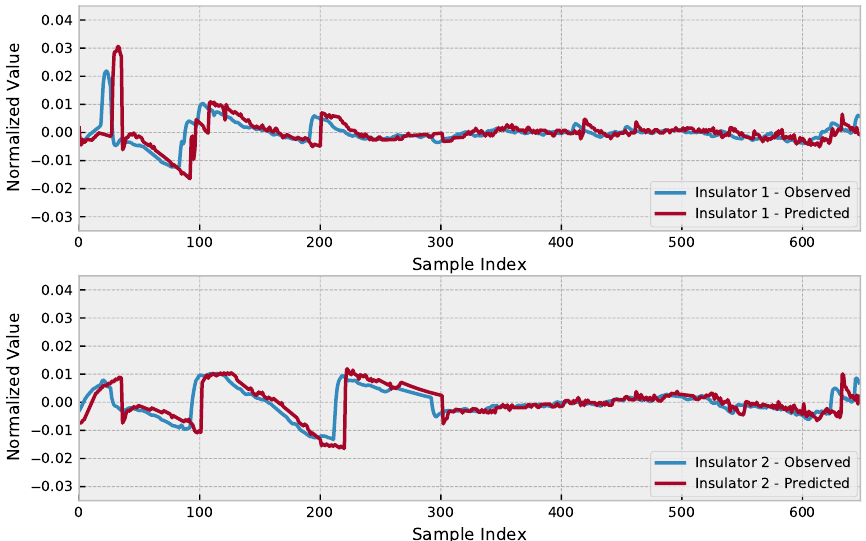
Figure 6. Prediction results compared to the observed signal.